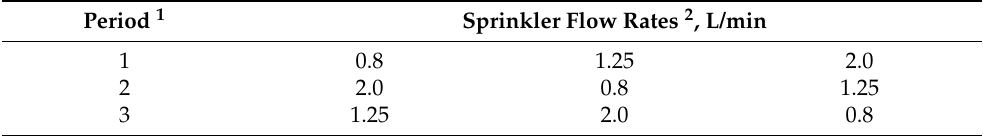
Table 1. Treatment application arrangement in a 3 × 3 Latin square design ( n = 9).